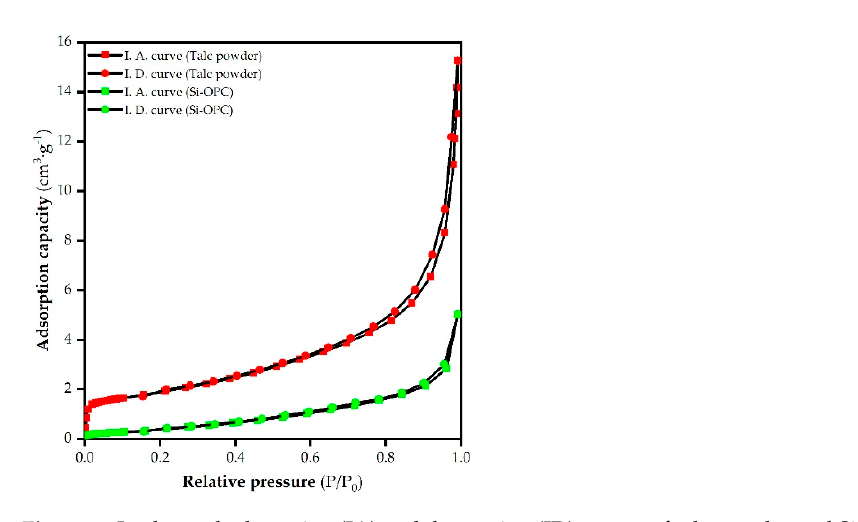
Figure 6. Isothermal adsorption (IA) and desorption (ID) curves of talc powder and Si-OPC ferti- lizer.